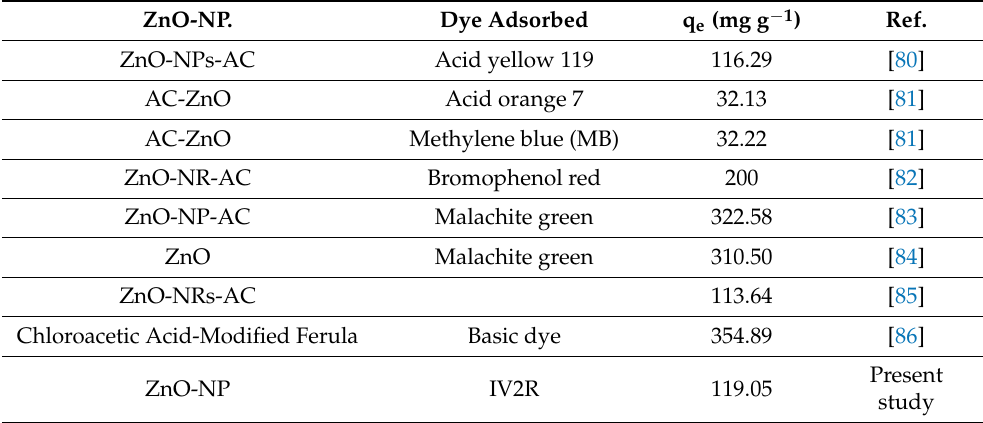
Table 7. Summary of the elimination of several dyes from aquatic mixtures by various ZnO-NPs.